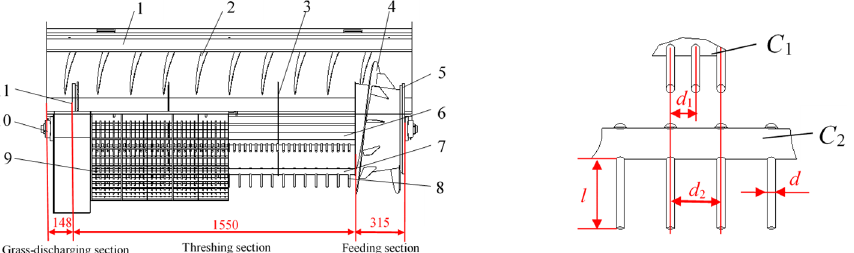
Figure 4. Schematic diagram of the longitudinal rod-teeth-type threshing device: (1) top cover; (2) deflector; (3) spoke disc; (4) auger of feeding section; (5) front end cap; (6) main axle; (7) mounting tube; (8) rod teeth; (9) concave sieve; (10) bearing block; (11) rear end cap .